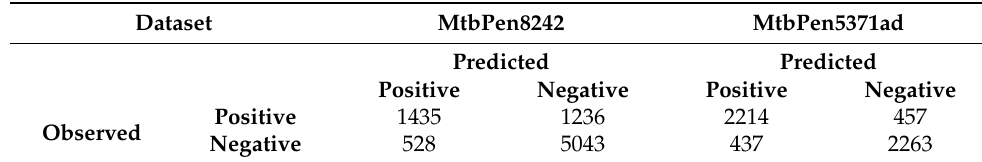
Table 1. Confusion matrices for the MtbPen classification models.